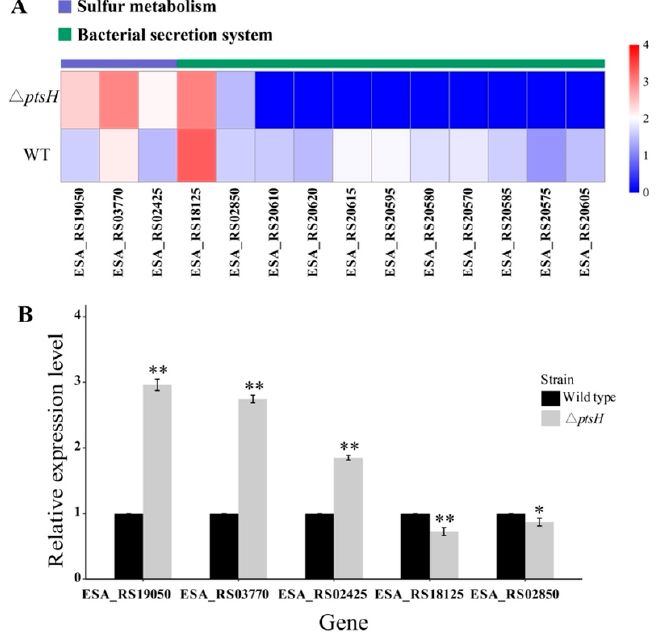
Figure 10. Heatmap of differentially expressed genes that were assigned to sulfur metabolism and bacterial secretion systems in the WT strain and Δ ptsH mutant ( A ). The color of the bar corresponds to different ranges of log 10 (FPKM+0.1). FPKM: fragments per kilobase of transcript sequence per millions base pairs that were sequenced. Transcription levels of genes that were related to sulfur metabolism and bacterial secretion systems in the WT strain and Δ ptsH mutant ( B ). ** p < 0.01, * p < 0.05 compared to the WT strain.